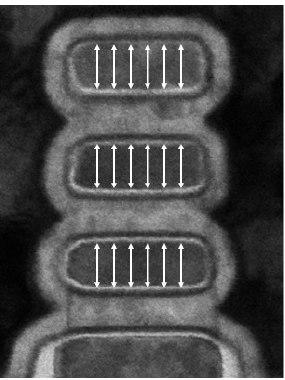
Figure 5. A TEM cross-section of GAA nanosheet FETs. The T Si is uniform in thickness along the W sheet direction [23].